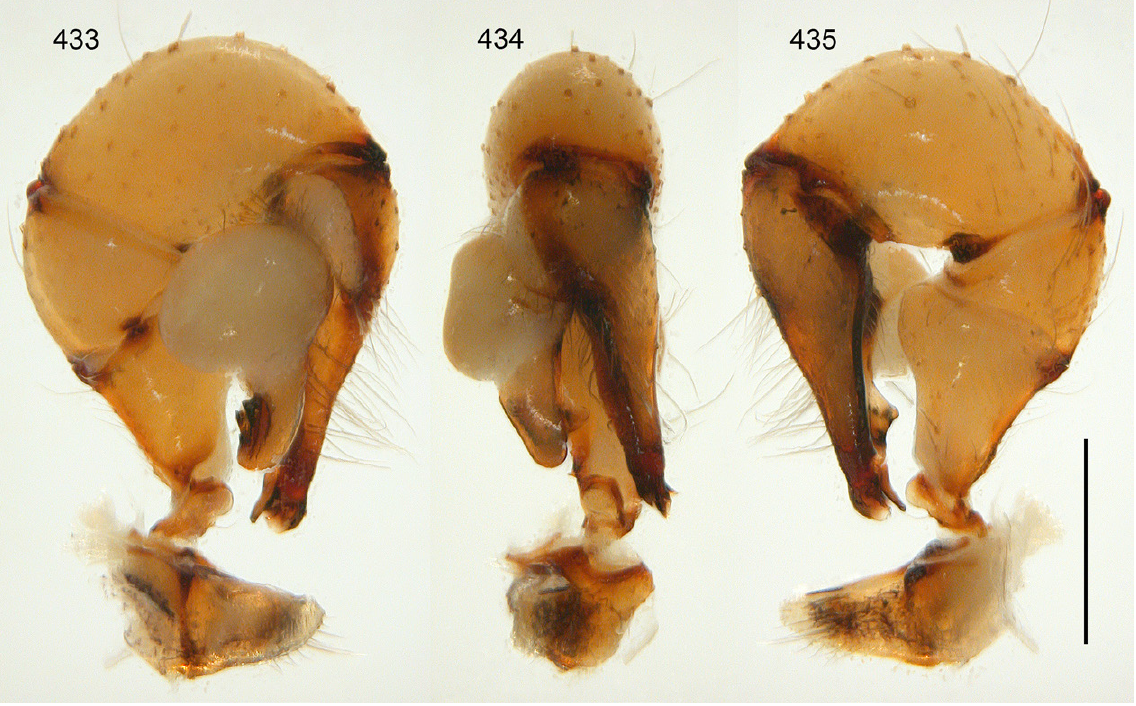
Figs 433–435. Crossopriza tiwi sp. nov.; male from Oman, Wadi Tiwi (ZFMK Ar 22402); left palp, prolateral, dorsal, and retrolateral views. Scale bar = 0.5